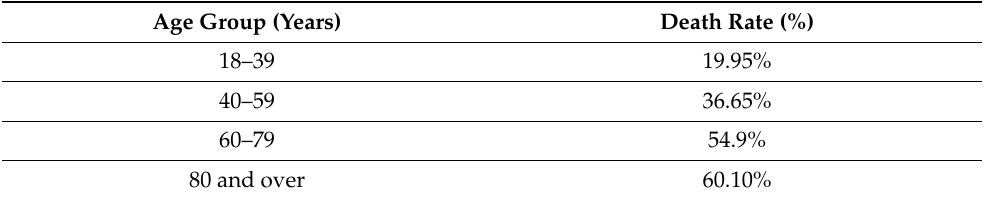
Table 3. Death rate by age group in a series of patients from Hidalgo, Mexico. Age Group (Years)